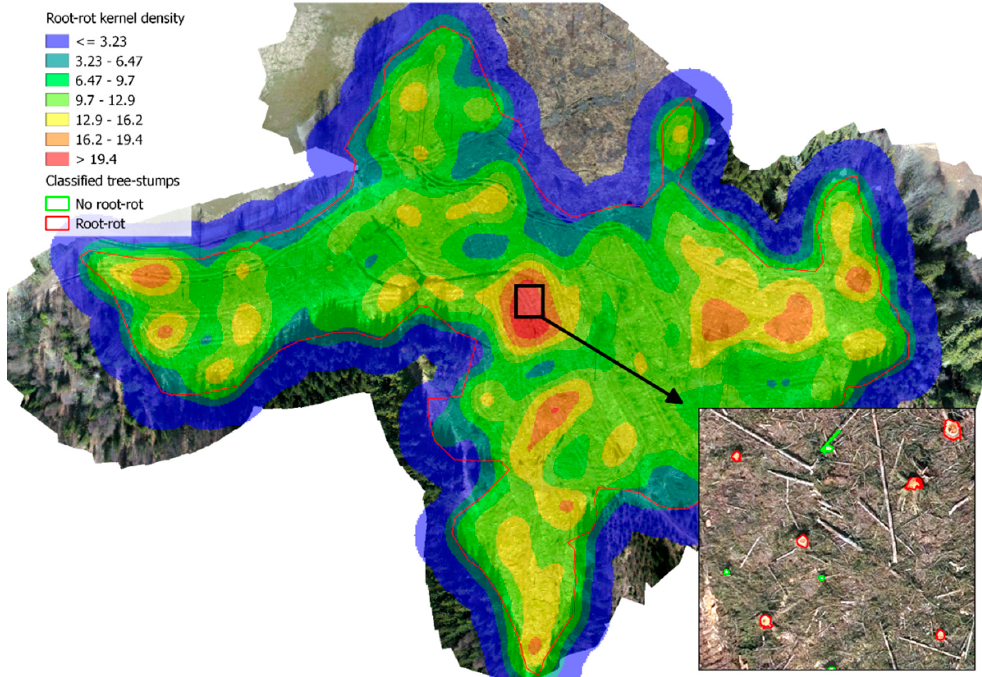
Figure 7. Heat map of the stumps with presence of root- and butt-rot calculated using kernel density. The warmer colours represent areas with largest density of stumps with root- and butt-rot, while the colder colours represent areas where it is less prevalent.